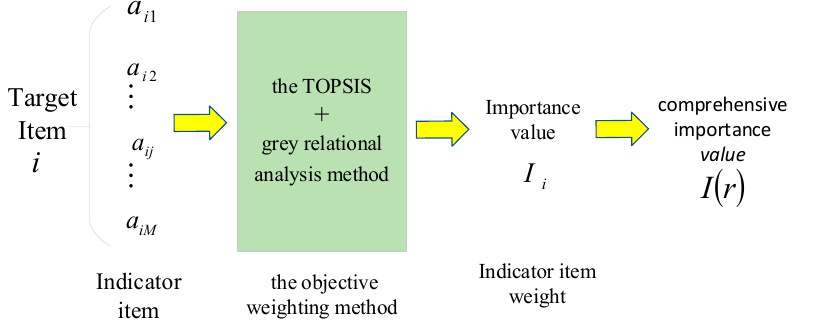
Figure 4. Assessment Methodology Flowchart.